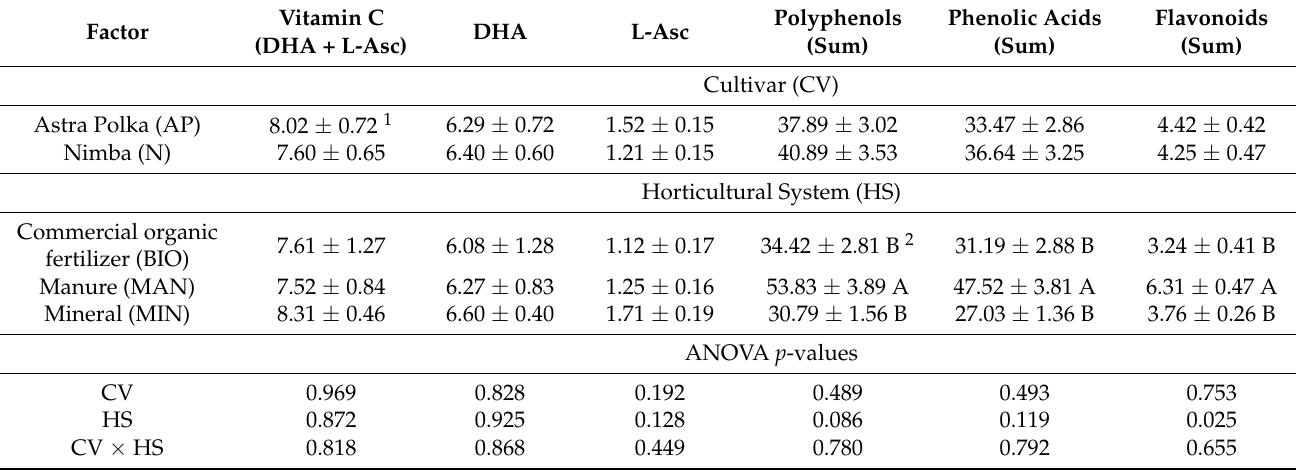
Table 3. The main effects of, and interactions between, cultivar and horticultural system on the content of vitamin C (mg/100 g f.w.) and selected groups of phenolic compounds ( µ g/g f.w.) in courgette fruits.